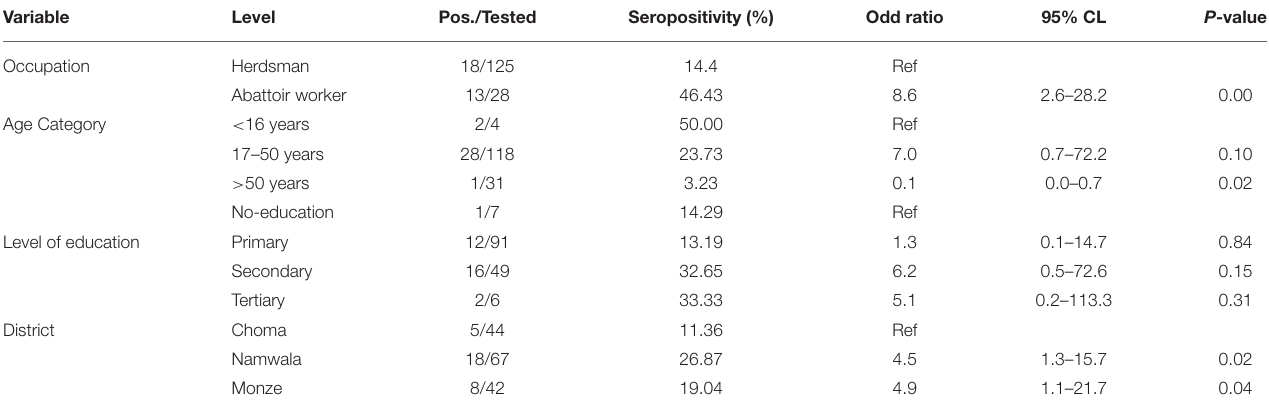
TABLE 4 | Multivariable logistic regression analysis for brucellosis risk factors in humans.